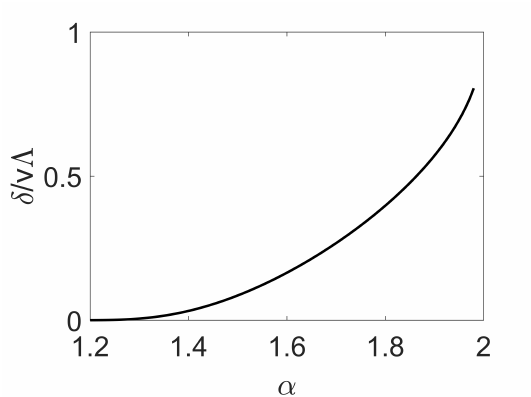
Figure 3: A plot of δ/ v Λ vs. α obtained by solving Eq. 17 in the case δ < v Λ . This shows the combination of parameters needed for Luttinger’s theorem to be